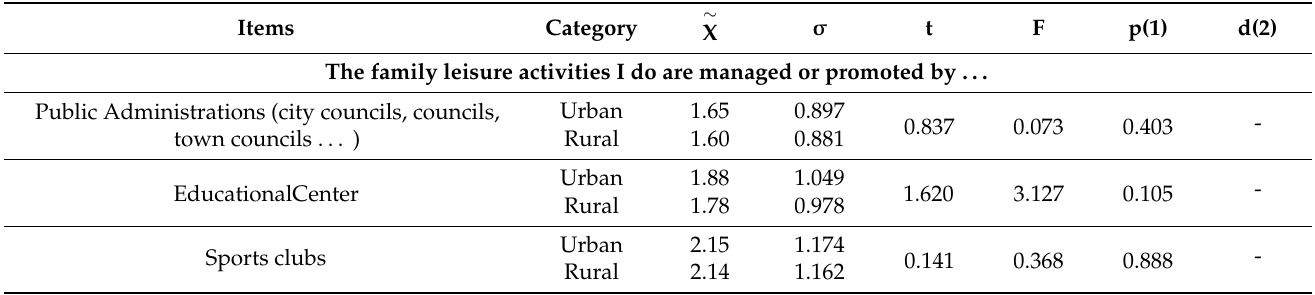
Table 5. Descriptive and inferential statistics of family leisure agents as a function of